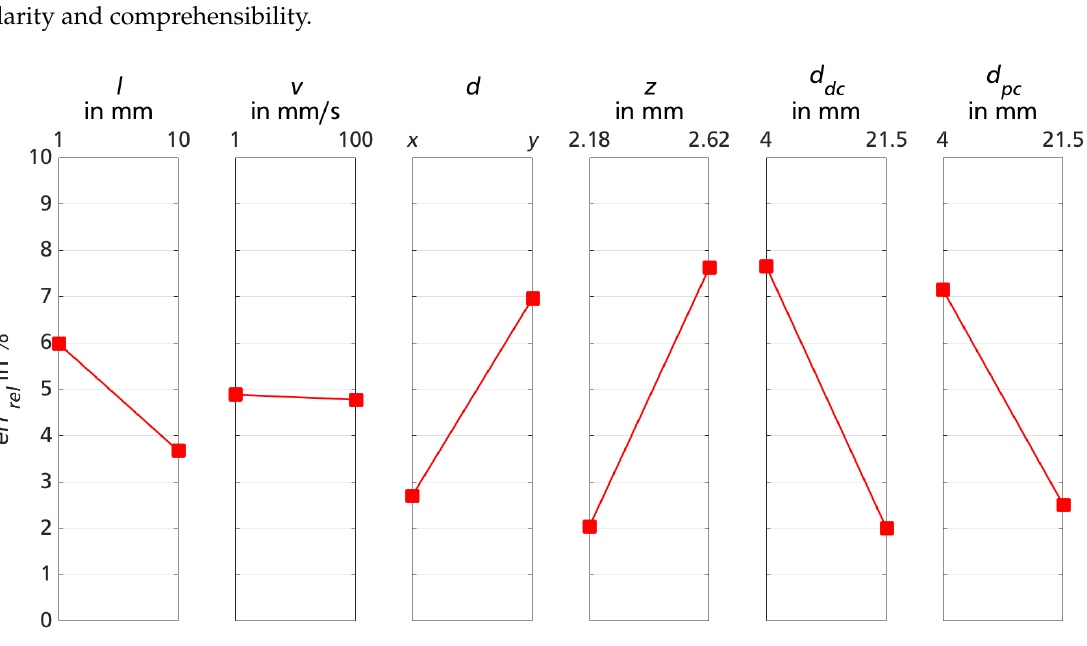
Figure 6. Effect lines for factor variation for measurements of trial session 2 on liner material